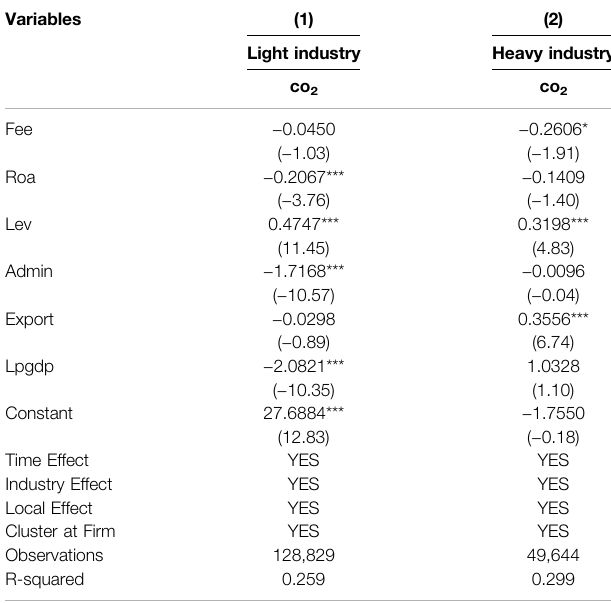
TABLE 9 | Heterogeneity — Light/heavy